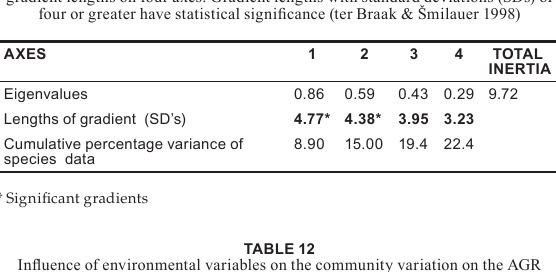
table 12 Influence of environmental variables on the community variation on the AGR computed by a Canonical Correspondence Analysis Monte Carlo Test. (full model. P-values ≤ 0.05 are significant (ter Braak & Šmilauer 1998)) enVironmental Variables